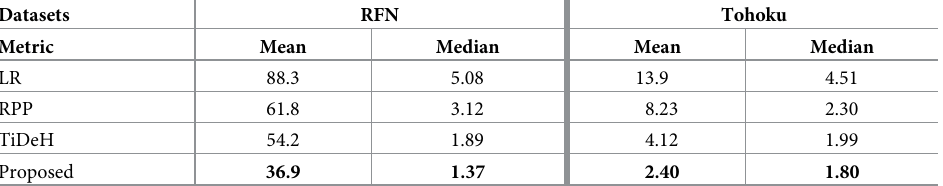
Table 3. Prediction performance on the two datasets: Mean and median absolute errors per hour. The best results are shown in bold for each